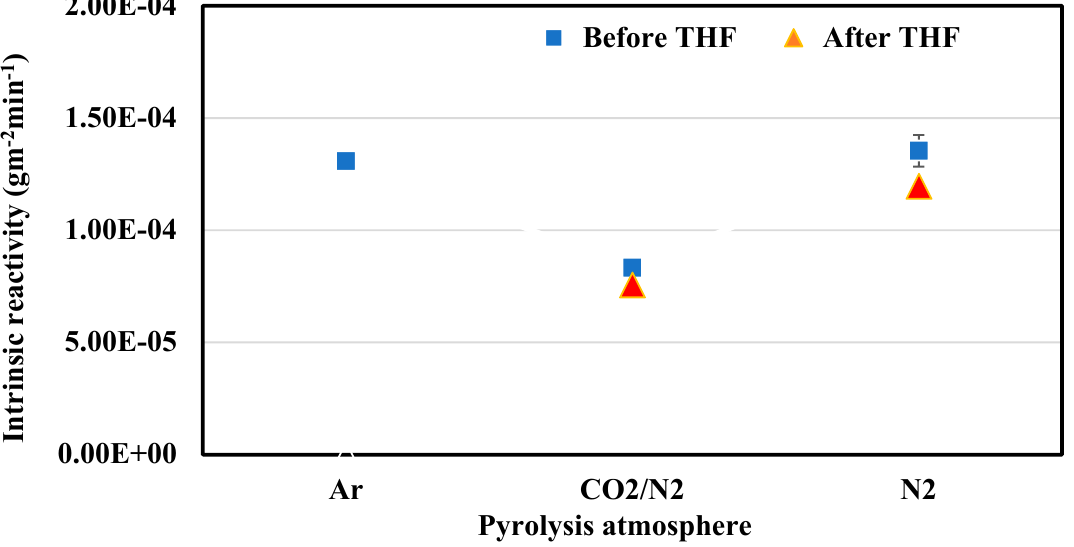
Figure 9 . Intrinsic reactivity of chars generated in various pyrolysis atmospheres.